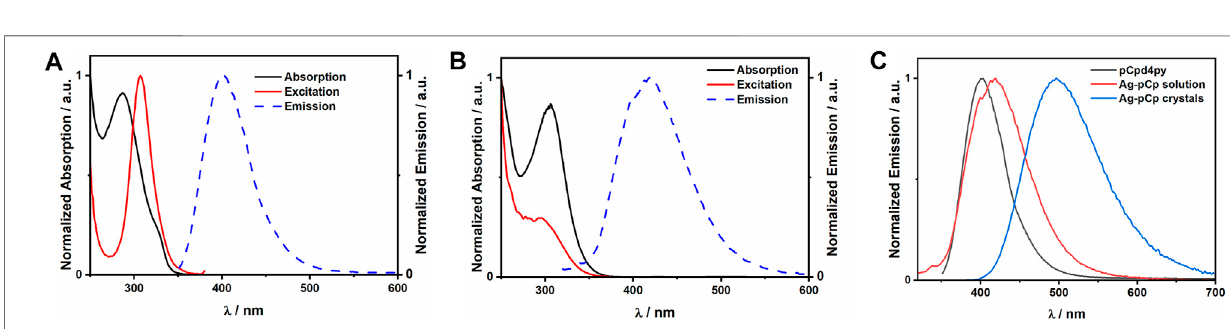
Frontiers in Chemistry |